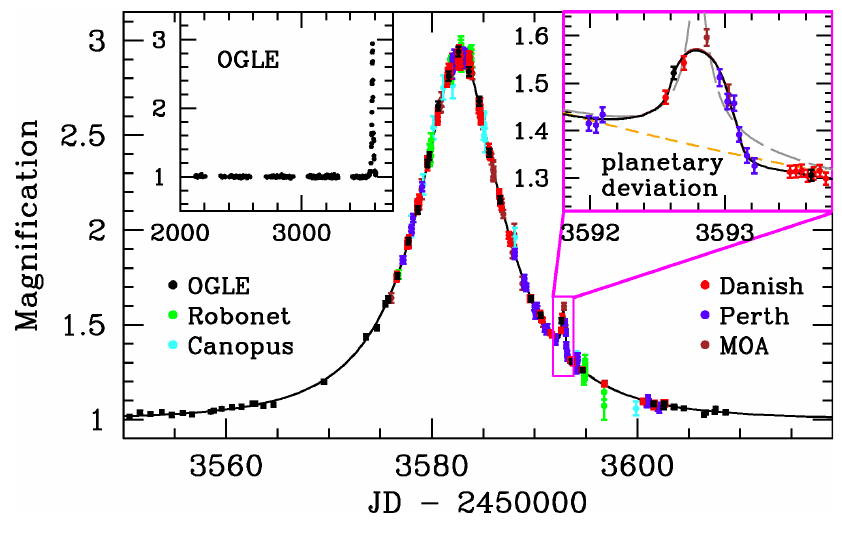
Figure 3. The light curve from a lensing event. The magnitude initially increases, peaks after about 20 days and then starts decreasing; the whole event lasting (cid:24) 50 days. In the absence of the influence of a companion, it would be symmetrical. In this case, however, a (cid:24) 5 : 5 Earth mass companion to the lens star, orbiting at (cid:24) 2 : 6 AU, causes an additional amplification (shown in the insert) that can be analysed to determine the mass and orbital distance of the companion. (Figure from